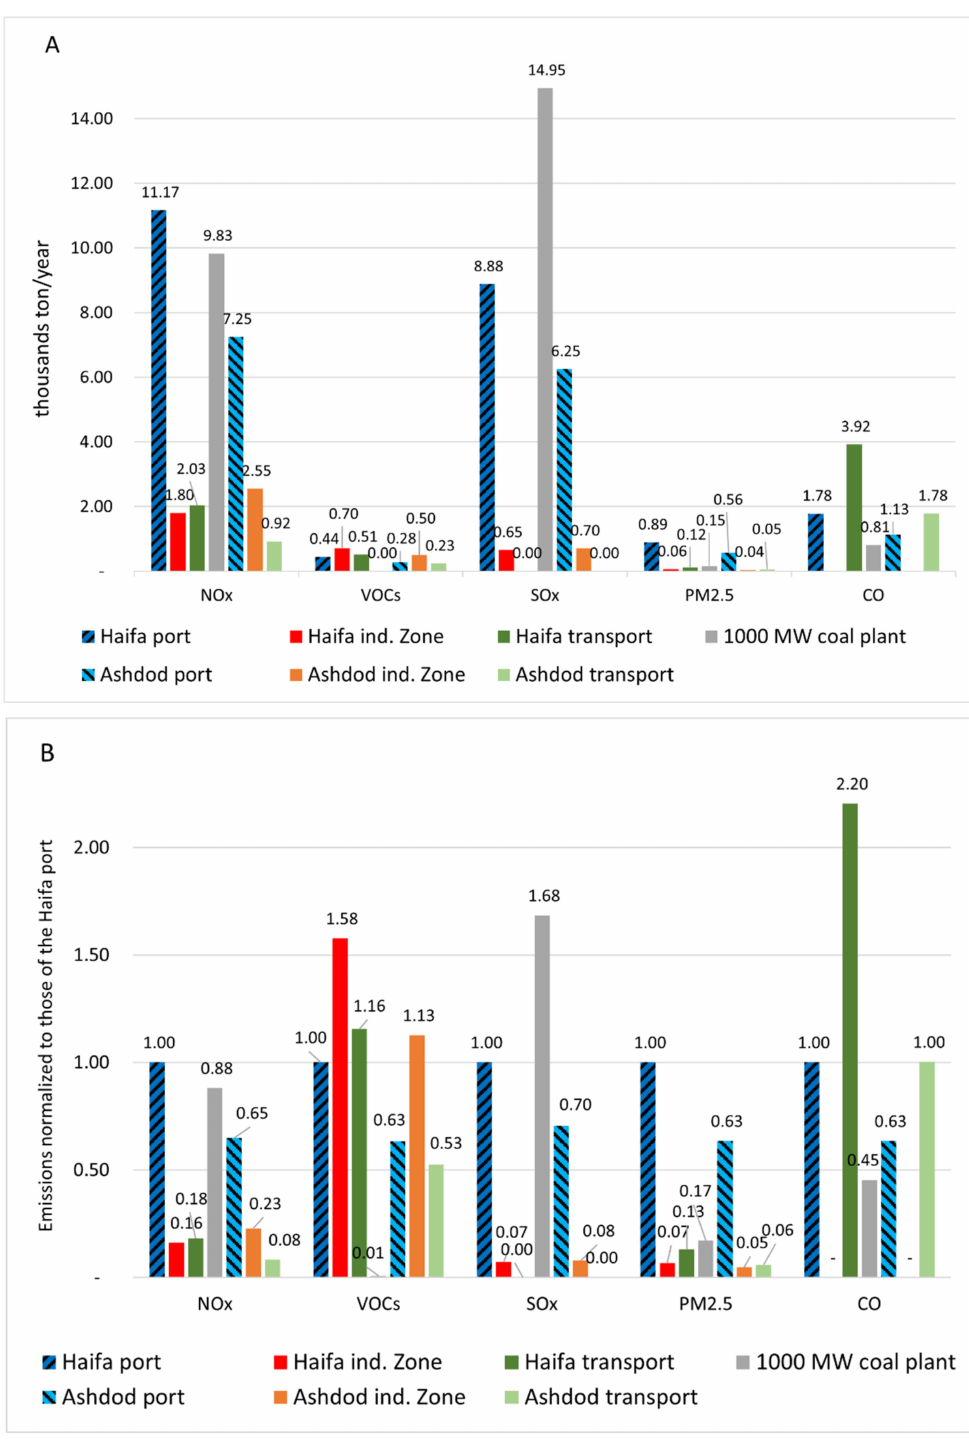
Figure 3. Calculated 2018 emissions from the Haifa and Ashdod ports, compared to other emission sources. The horizontal axis shows different air emissions: NOx, VOCs, SOx, PM 2.5 and CO; and their sources. Calculation uncertainties are provided in Appendix B. Dark blue stripes: Haifa port, red- Haifa Bay industrial zone, dark green: Haifa metropolitan land transportation, grey: a typical 1000 MW coal power plant, light blue stripes: Ashdod port, orange- North Ashdod industrial zone, light green- Ashdod land transportation. ( A ) Absolute emission values. Y axis is air pollutant emission in thousands ton/year. ( B ) Normalized emissions to the Haifa port emissions. Y axis is air pollutant emission normalized to that of the Haifa